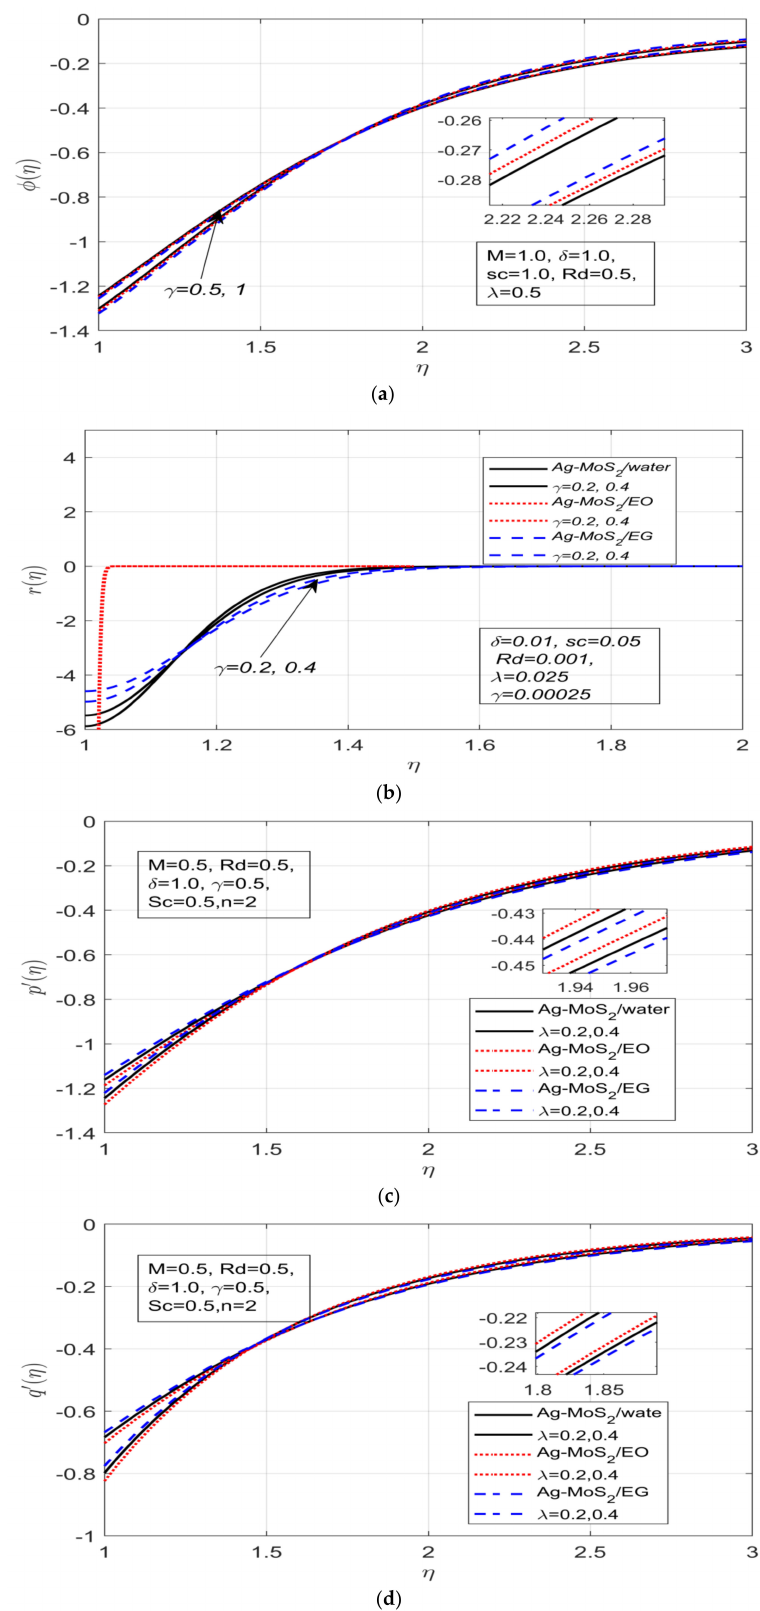
Figure 4. ( a ) The impact of stretching ratio γ on the concentration profile φ . ( b ) The impression of the stretching ratio γ on the temperature profile r . ( c ) The impact of rotation λ on the primary velocity p (cid:48) . ( d ) The impact of rotation λ on the secondary velocity q (cid:48)